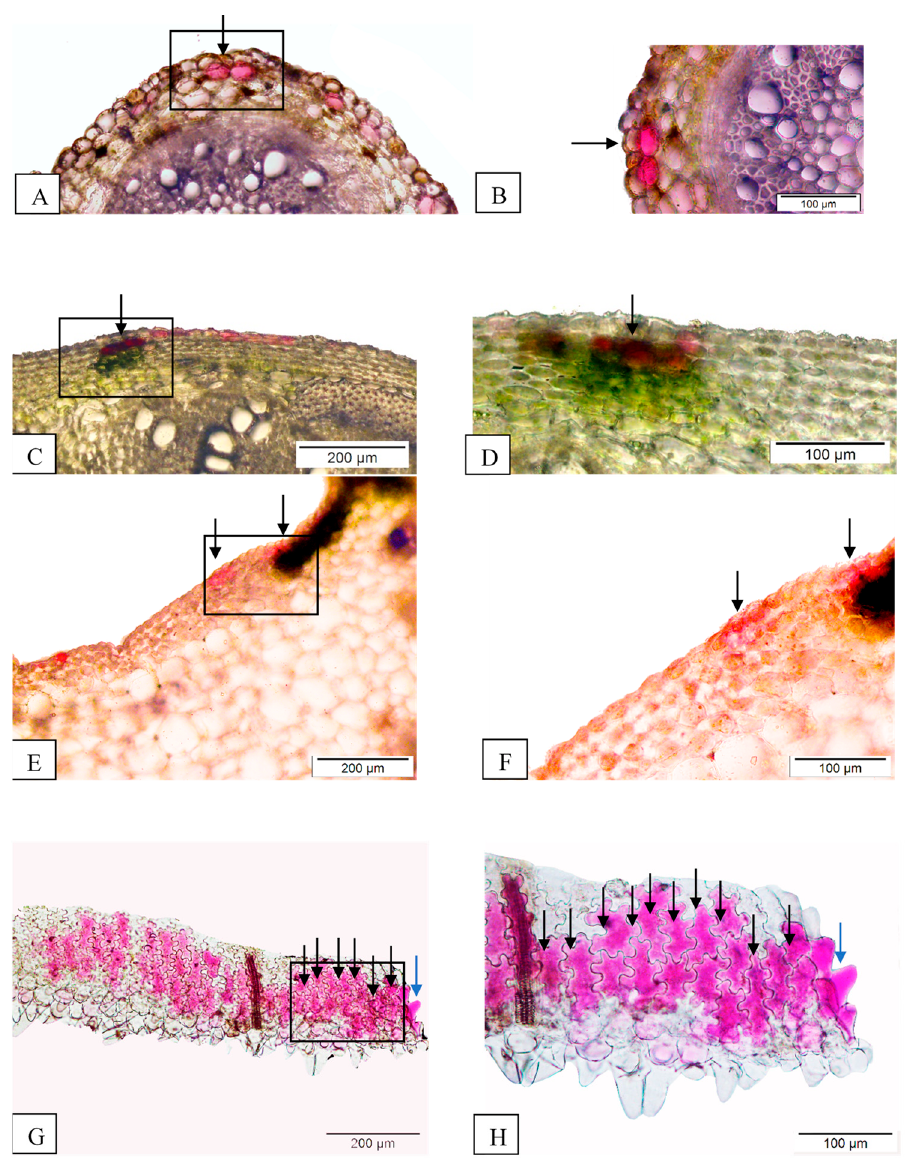
Figure 8. Transverse anatomy sections of different tissues of C. caudatus , root: ( A , B ), stem: ( C , D ), leaf petiole: ( E , F ), and floral petal: ( G , H ). ( A , C , E , G ) are under magnification 10 × , whereas ( B , D , F , H ) are under magnification 20 × , of the respective tissue’s focused region (black box). Black arrows indicate localization of anthocyanins (pigmentation) at the adaxial epidermis, and blue arrows point to the localization in the papillae.